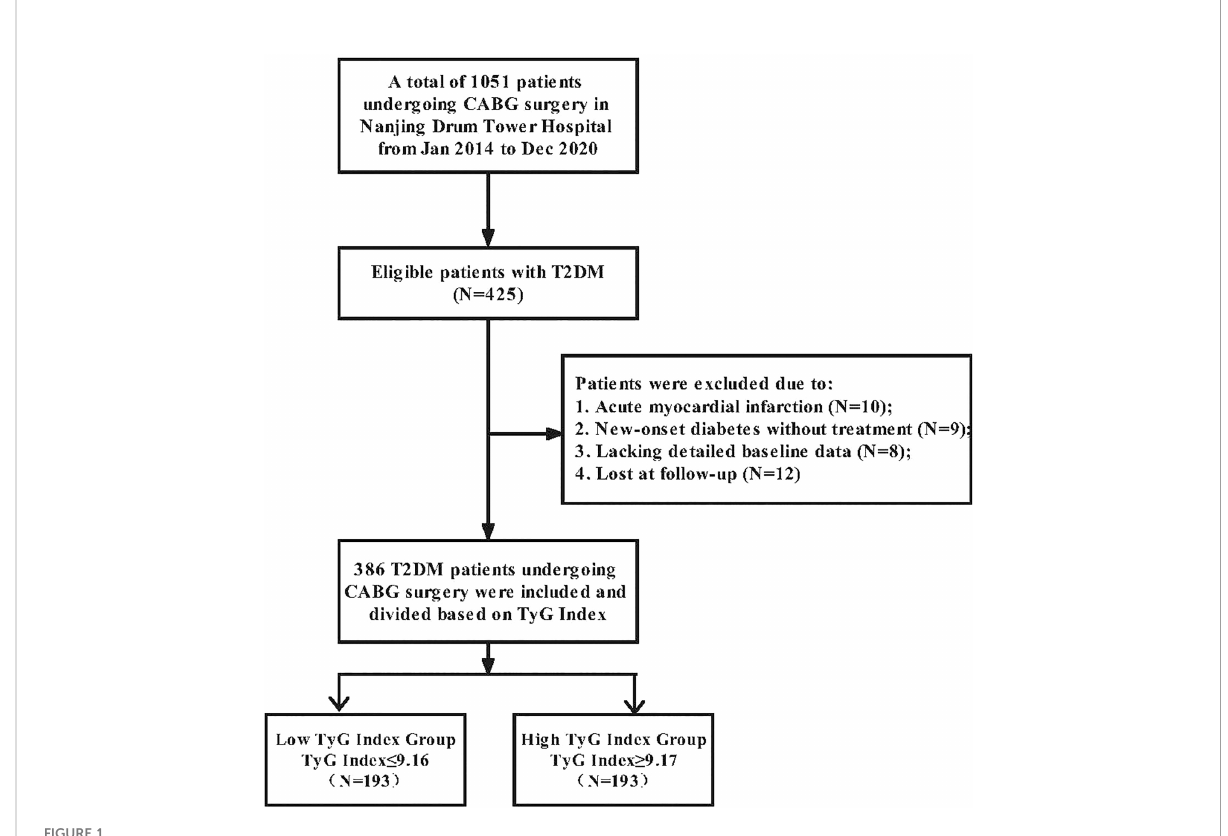
FIGURE 1 Flowchart of participant